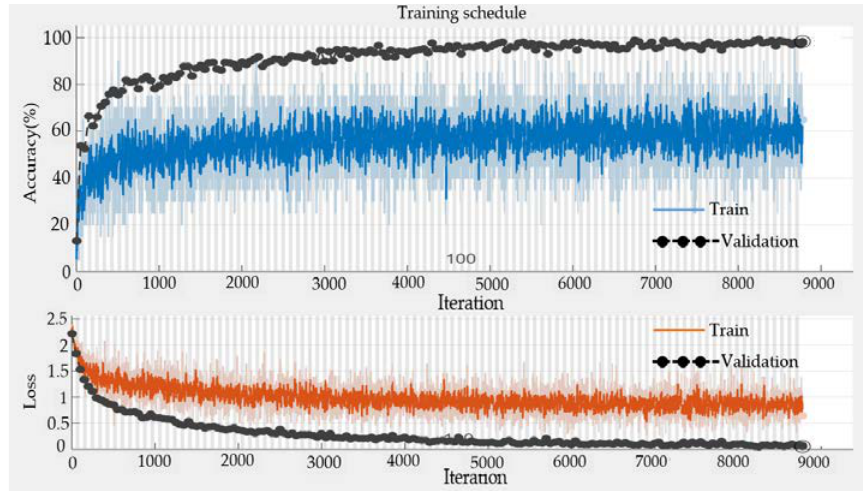
Figure 14. CNN model training schedule.